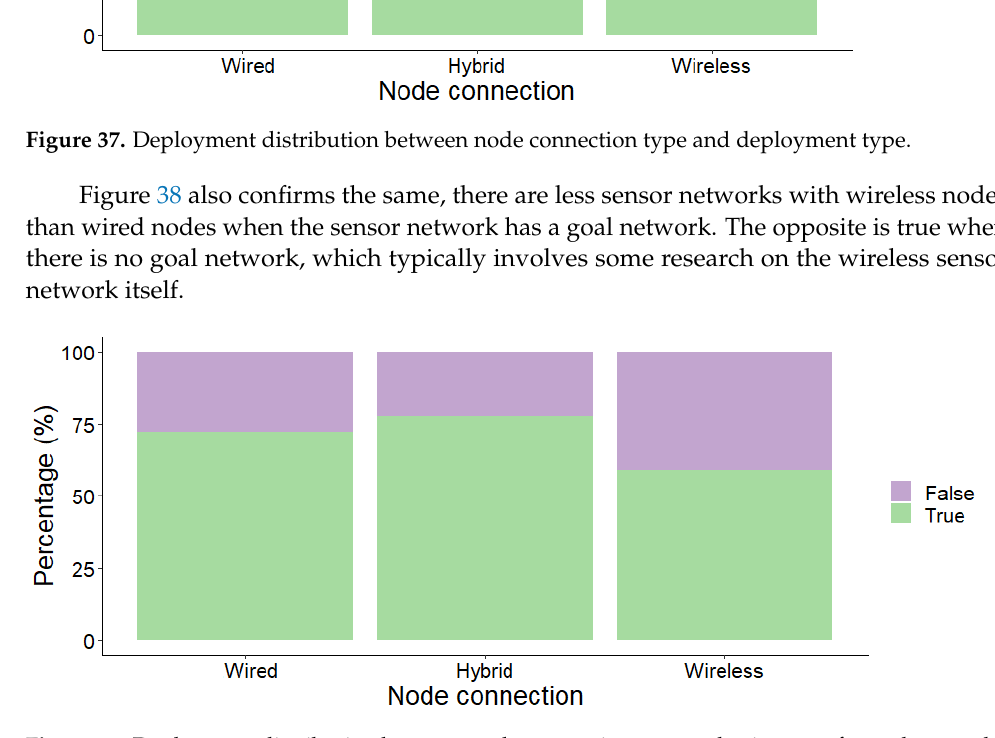
Figure 38. Deployment distribution between node connection type and existence of a goal